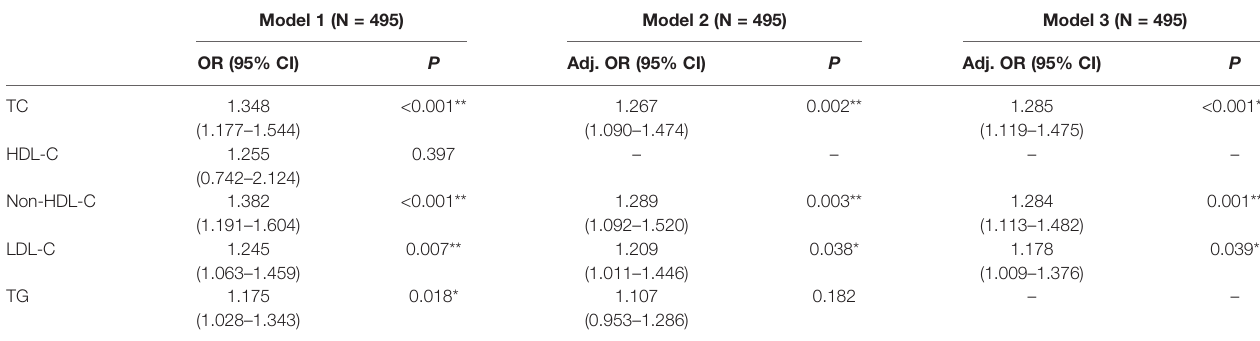
TABLE 4 | Logistic regression analyses for lipid pro fi les and PLA2R